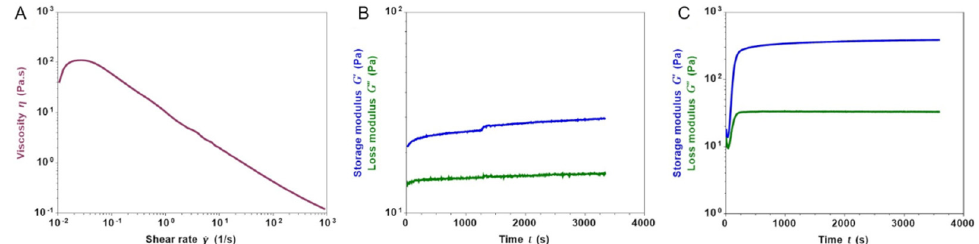
Figure 7. Shear thinning ( A ) and stability of the storage (G ′ ) and loss (G ″ ) modulus values of the Coll/LPMS-HRP_PEG_TG suspension over time ( B ) at 10 °C. Sol-gel transition of the com- posite system at 37 °C ( C ).